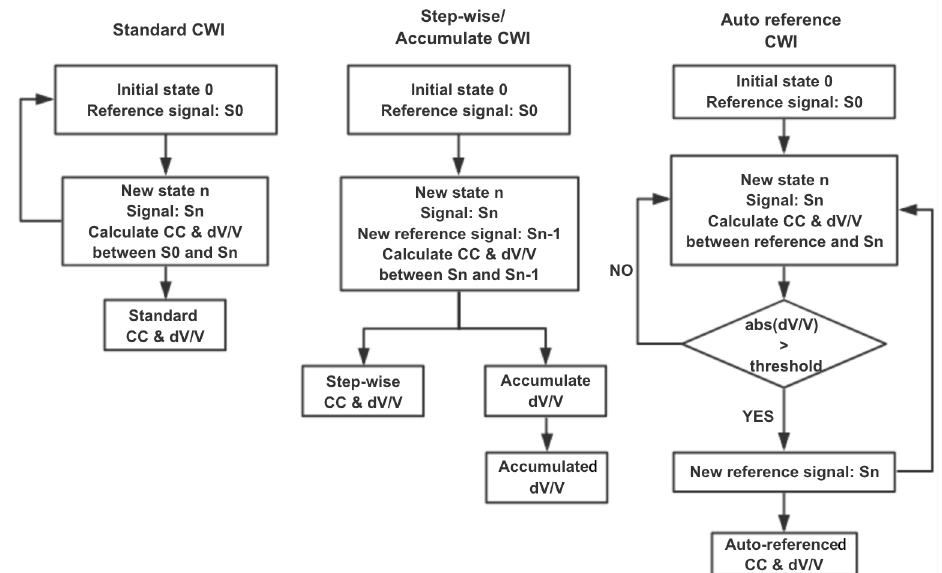
Figure 2. Algorithm of three CWI methods.